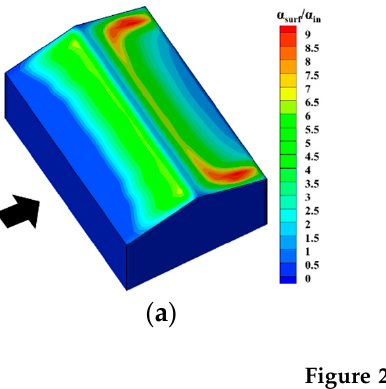
Figure 19. Normalized friction velocity Figure 20. Normalized volume fraction of drifting snow α surf / α in on the gable roof: ( a ) volume frac- tion: 7.8 × 10 − 6 ; ( b ) volume fraction: 1.56 × 10 − 5 ; ( c ) volume fraction: 2.34 × 10 − 5 .